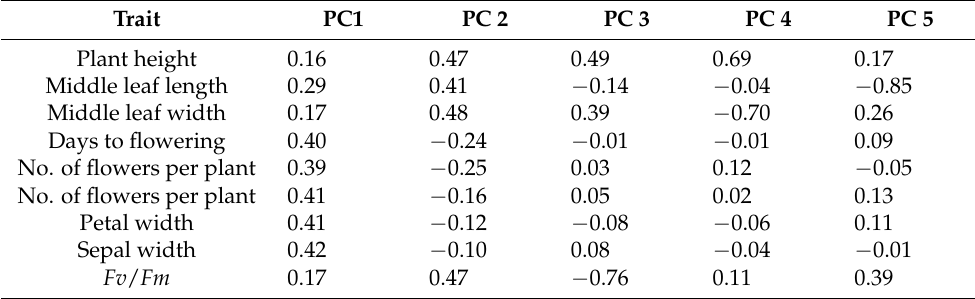
Table 4. Principal component analysis for the five principal components of cut flower and growth traits from differences between salt treatment and control. PC1, PC2, PC3, PC4, and PC5